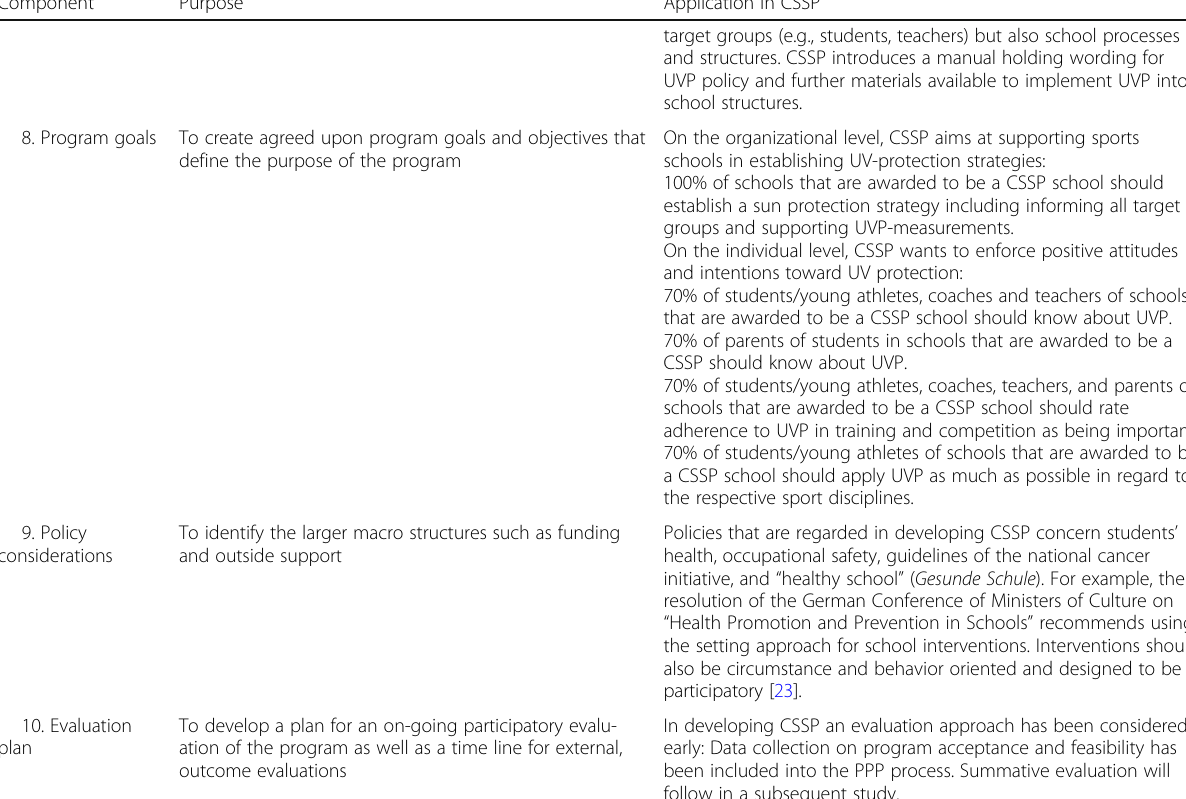
Table 1 Program planning components and their application in the Clever in Sun and Shade Program (CSSP) (Continued)